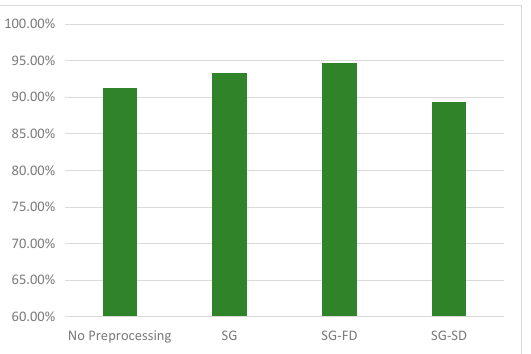
Figure 5. Comparison of the effects of different pretreatment methods on LDA model at full wave- length.